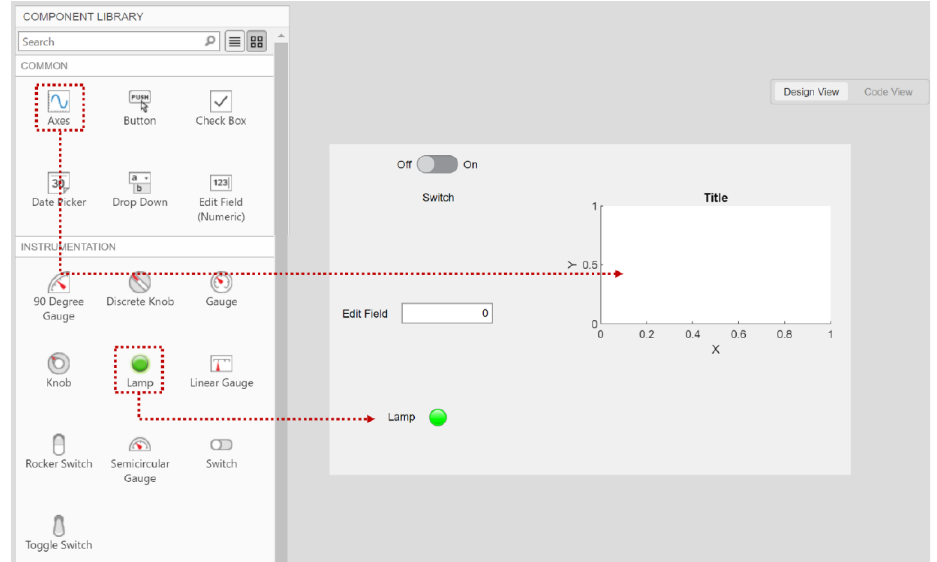
Figure 11. The design view browser inside MATLAB app development environment. The dynamic objects are chosen from a component library and are populated into the GUI canvas.